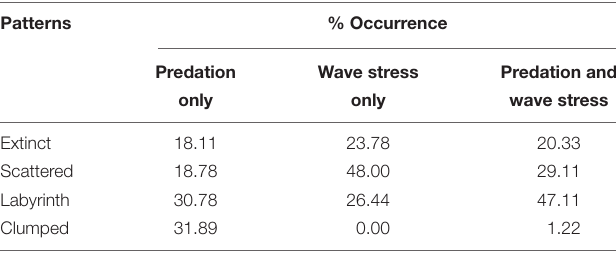
TABLE 1 | Each set of parameters brings about different selection gradients, resulting in different evolutionary attractors and corresponding emergent spatial